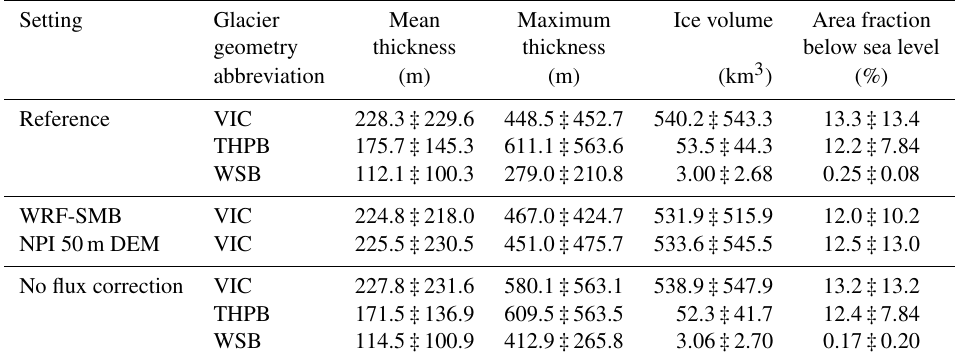
Table C1. Reconstruction sensitivity as quantified by the mean and maximum ice thickness, the ice volume and the area fraction grounded below sea level. The ‡symbol separates values stemming from a reconstruction using either all or only a 1% fraction of the available thickness